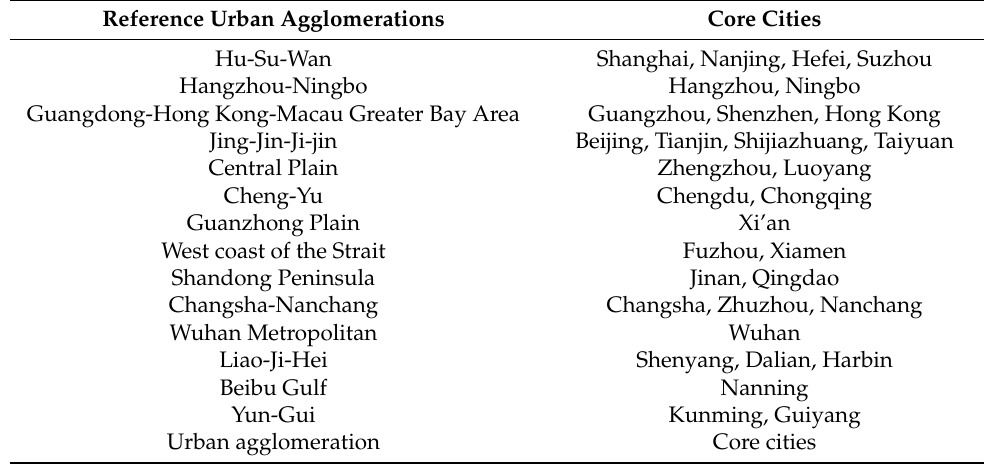
Table 1. Reference urban agglomerations and core cities.